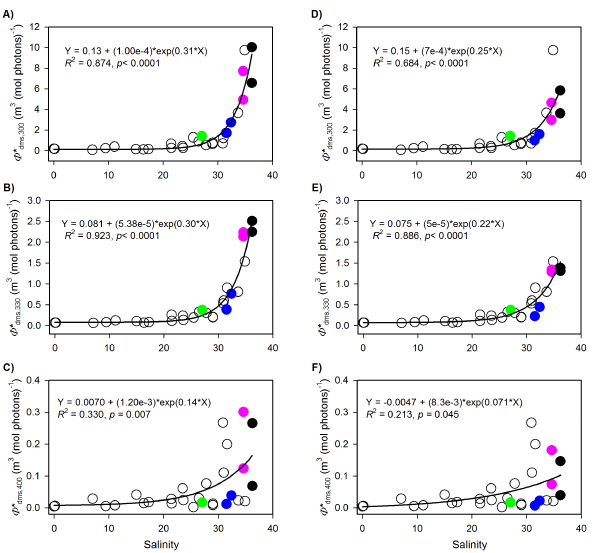
Fig. 4. Scatter plots of DMS photolysis AQY versus salinity for AQY at 300 (a, d) , 330 (b, e) , and 400nm (c, f) . Open circles de- note data from this study, filled blue circles from the Bering Sea (Deal et al., 2005), filled red circles from the NE subarctic Pacific (Bouillon and Miller 2004, their out-patch values), filled black cir- cles from the Sargasso Sea (Toole et al., 2003). The solid green circles signify data obtained from a sample freshly collected from the lower St. Lawrence estuary off Mont-Joli, Québec (48.5833 ◦ N, 68.1833 ◦ W). DMS AQYs in panels (a–c) were not corrected for temperature dependence; in panels (d–f) , DMS AQYs for the Sar- gasso Sea, NE Pacific, and Bering Sea were scaled to 4 ◦ C (the ir- radiation temperature in the present study) based on the result of Toole et al. (2003). Solid lines are best fits to the data.